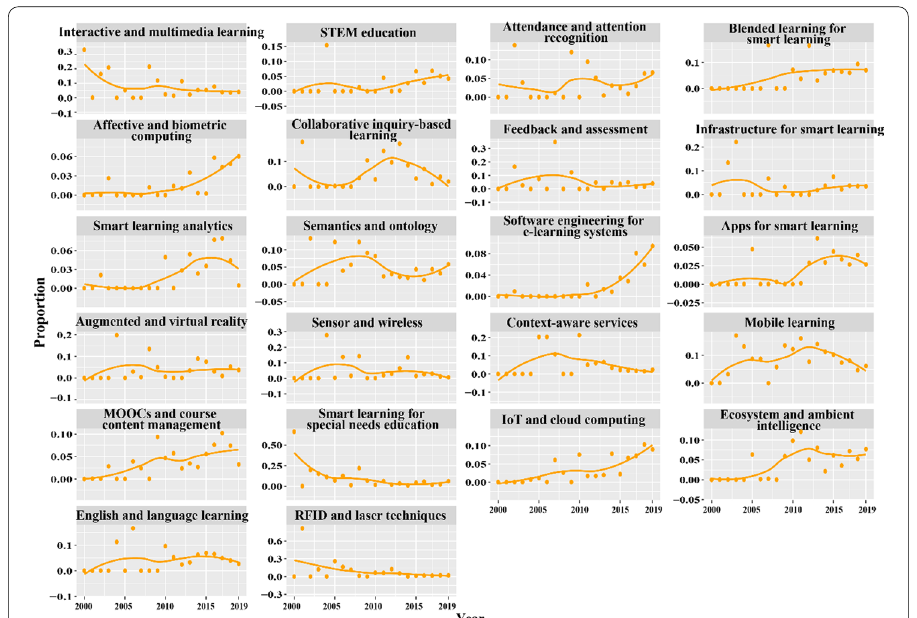
Fig. 7 Visualization of the annual proportion of the 22 research